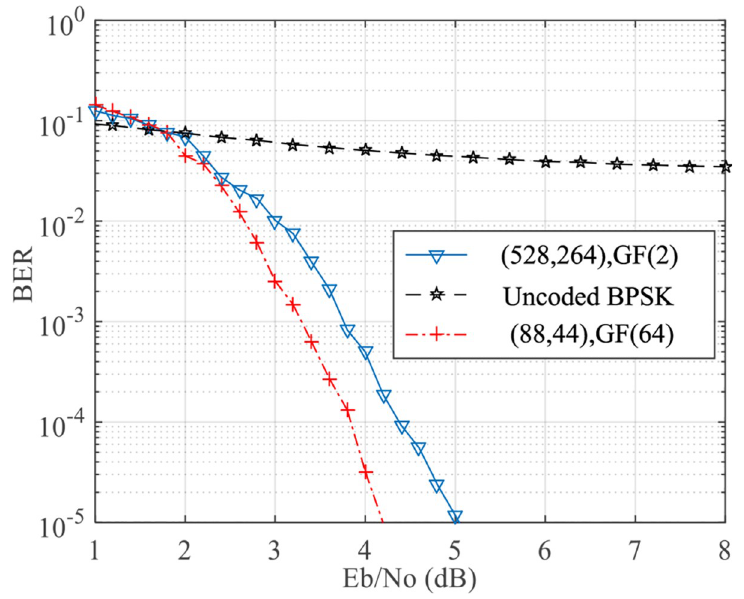
Secondly, the BER performance of LDPC code (88, 44) over GF(64) was compared with the binary LDPC code (528,264) on AWAN channel with A = 0.1, Γ = 0.1 in Fig 6. The decoding algorithm of binary LDPC codes on AWAN channel was introduced by Nakagawa et al. in [27]. Fig 6 demonstrates that the BER performance of binary LDPC codes on AWAN channel